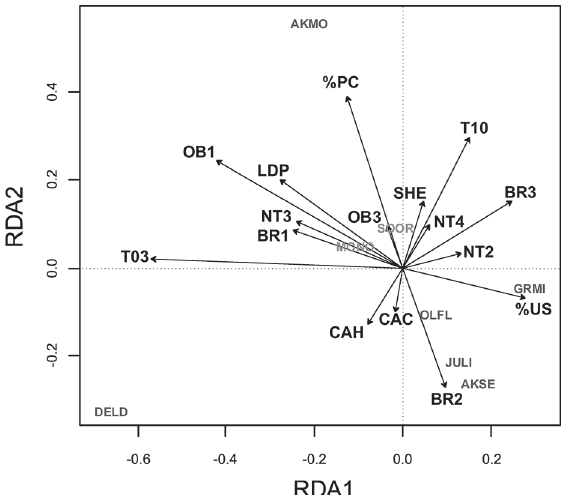
Fig. 2 - Ordination diagram from redundancy analysis of the small mammals’ species and microhabitat variables. Species are indicated by codes: AKMO = Akodon montensis ; AKSE = Akodon serrensis ; DELD = Delomys dorsalis ; JULI = Juliomys sp.; GRMI = Gracilinanus microtarsus ; MONO = Monodelphis dimidiata ; OLFL = Oligoryzomys flavescens ; SOOR = Sooretamys angouya . Microhabitat codes: %PC = percentage of plant cover on the ground; %US = percentage of uncovered soil; BR1 = number of bromeliad plant up to 1.0 m height; BR2 = number of bromeliad plant between 1.1 and 5.0 m height; BR3 = number of bromeliad plant above 5.0 m height; CAC = canopy cover; CAH = canopy height; LDP = litter depth; NT2 = number of trees and shrubs with d.b.h. between 10.1 and 20.0 cm; NT3 = number of trees and shrubs with d.b.h. between 20.1 and 40.0 cm; NT4 = number of trees and shrubs with d.b.h. above 40.0 cm; OB1 = horizontal obstruction at 0.5 m; OB3 = horizontal obstruction at 1.5 m; SHE = number of potential shelters; T03 = distance of the nearest tree with d.b.h. between 3 and 10 cm; T10 = distance of the nearest tree with d.b.h. greater than 10